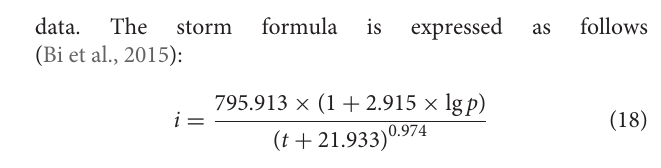
and 284 m wide, the cross-sectional width consists of a